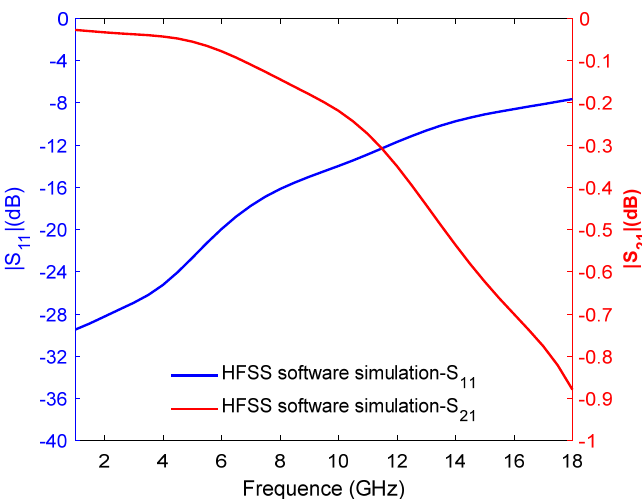
Figure 3. Structure-electromagnetic analysis model for FCWI.